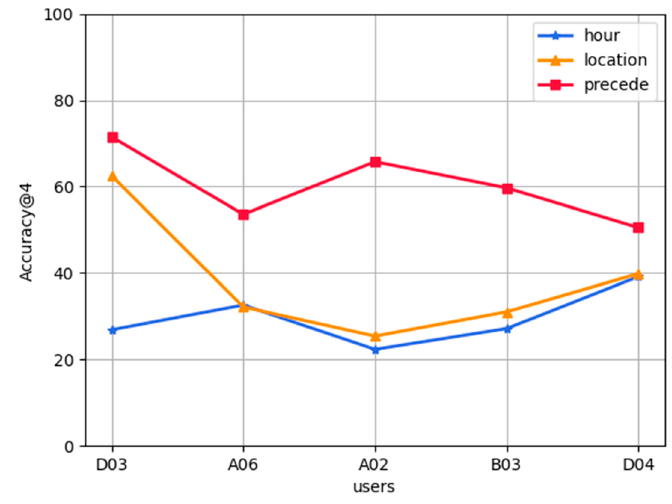
Figure 8. Cold start prediction of new users.